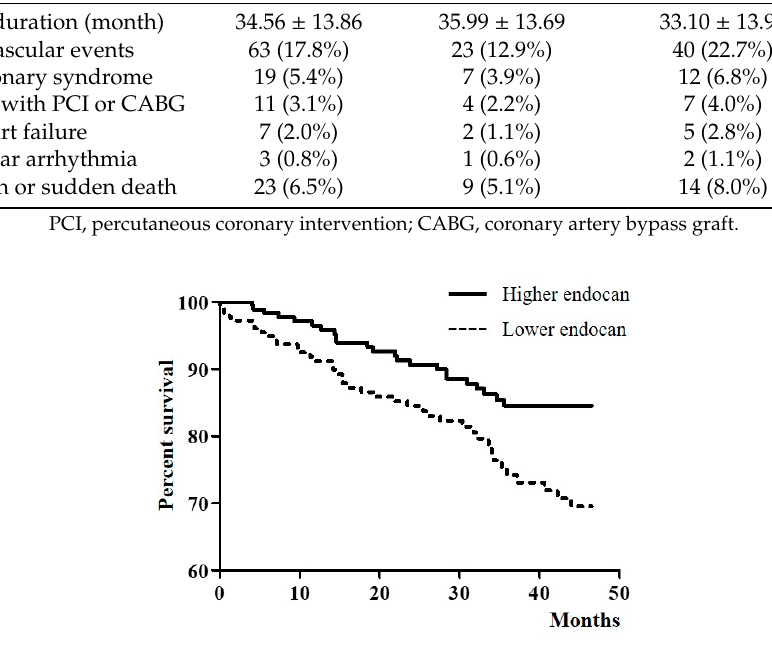
Figure 1. Cardiovascular event-free survival according to plasma endocan level. Table 4. Predictors of cardiovascular events in univariate and multivariate Cox regression